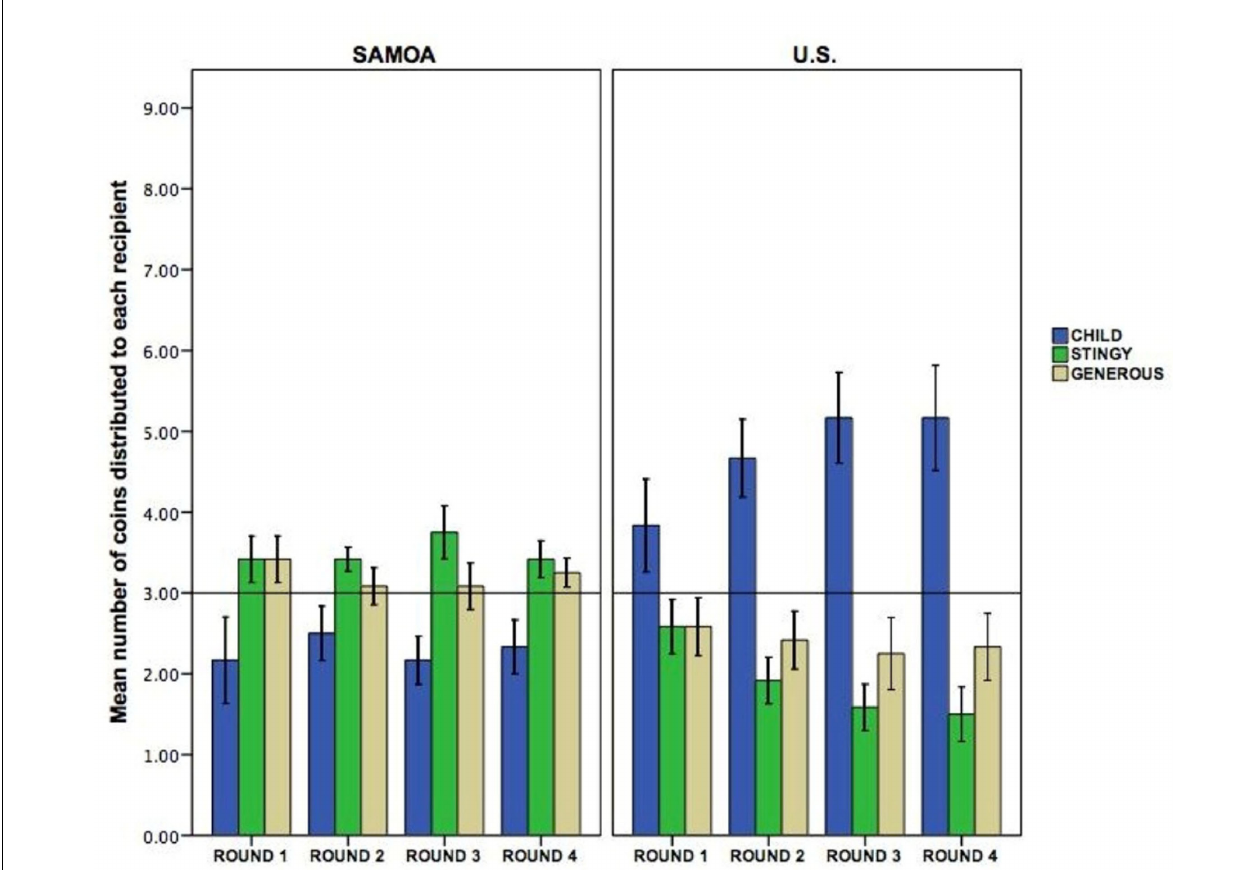
sample of age and gender-matched children from Study 2 (right panel) to each protagonist (child, left puppet, right puppet) as a function of round (1–4).The horizontal line represents absolute equity (three coins). Bars represent ± 1